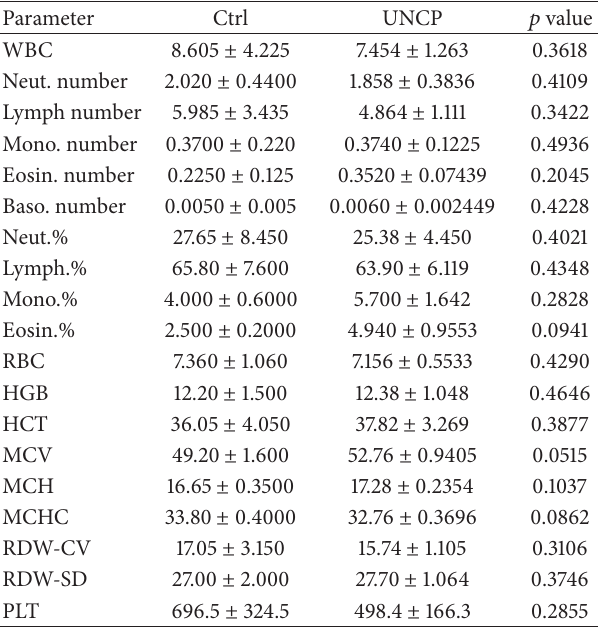
Table 6: Changes in haematological indices in male SD rats receiving 2000 mg/kgb.w.t. of